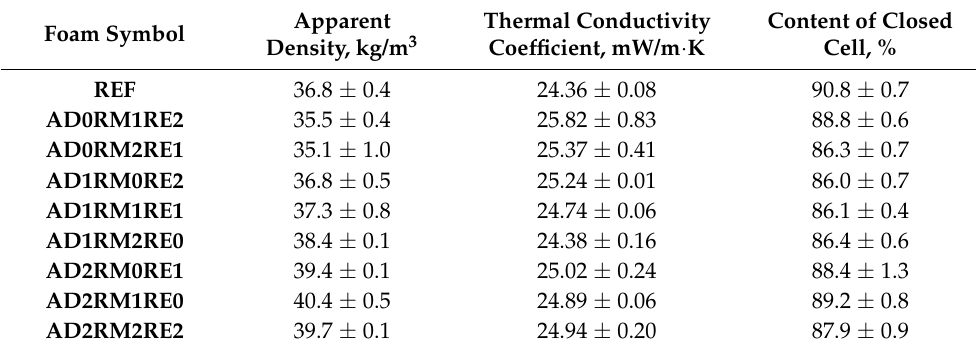
Table 4. Thermal conductivity coefficient, apparent density, and content of the closed cell of rigid polyurethane foams. Apparent Thermal Conductivity Content of Closed Foam Symbol Density, kg/m 3 Coefficient, mW/m · K Cell, % REF 36.8 ± 0.4 24.36 ± 0.08 90.8 ± 0.7 AD0RM1RE2 35.5 ± 0.4 25.82 ± 0.83